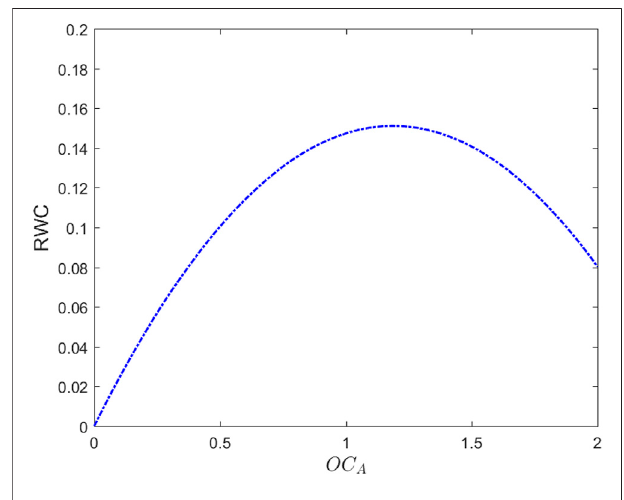
FIGURE 1 | Numerical simulations ofRWC A ( c (cid:2) 0 . 5 , τ (cid:2) 0 . 2 , δ (cid:2) 0 . 15 , α (cid:2) 5 , c A (cid:2) 1 . 1 , c B (cid:2) 1 . 9 . )